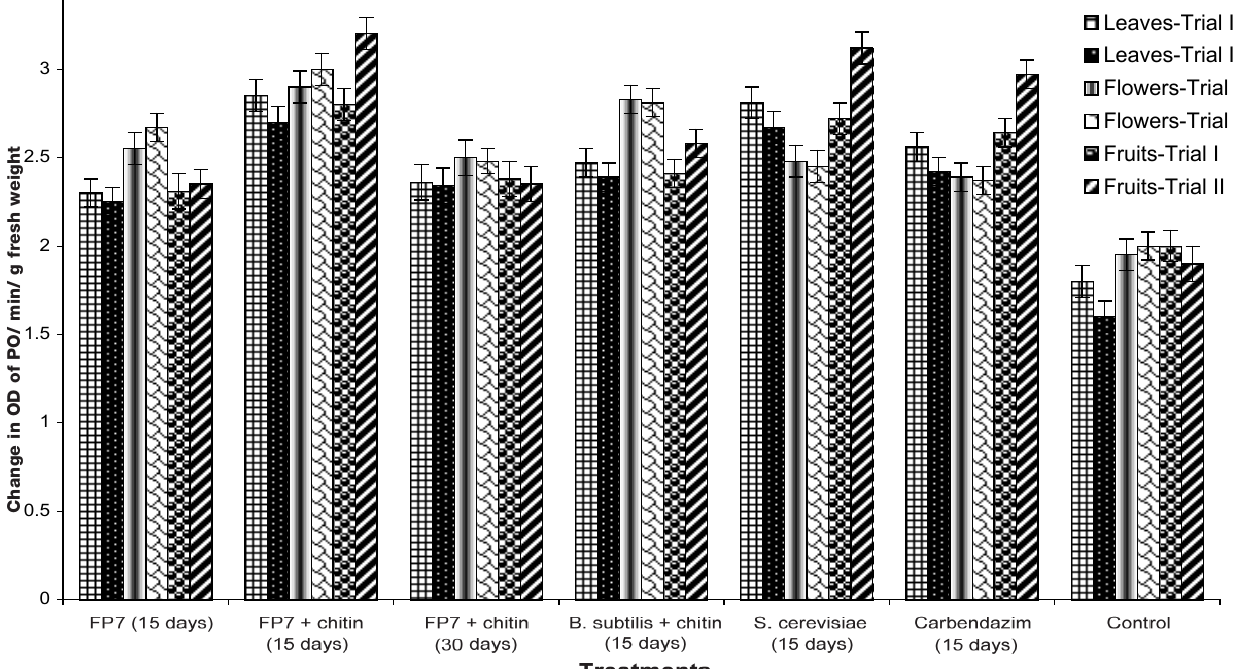
Fig. 6. Effect of pre-harvest application of biocontrol formulations on induction of peroxidase in mango